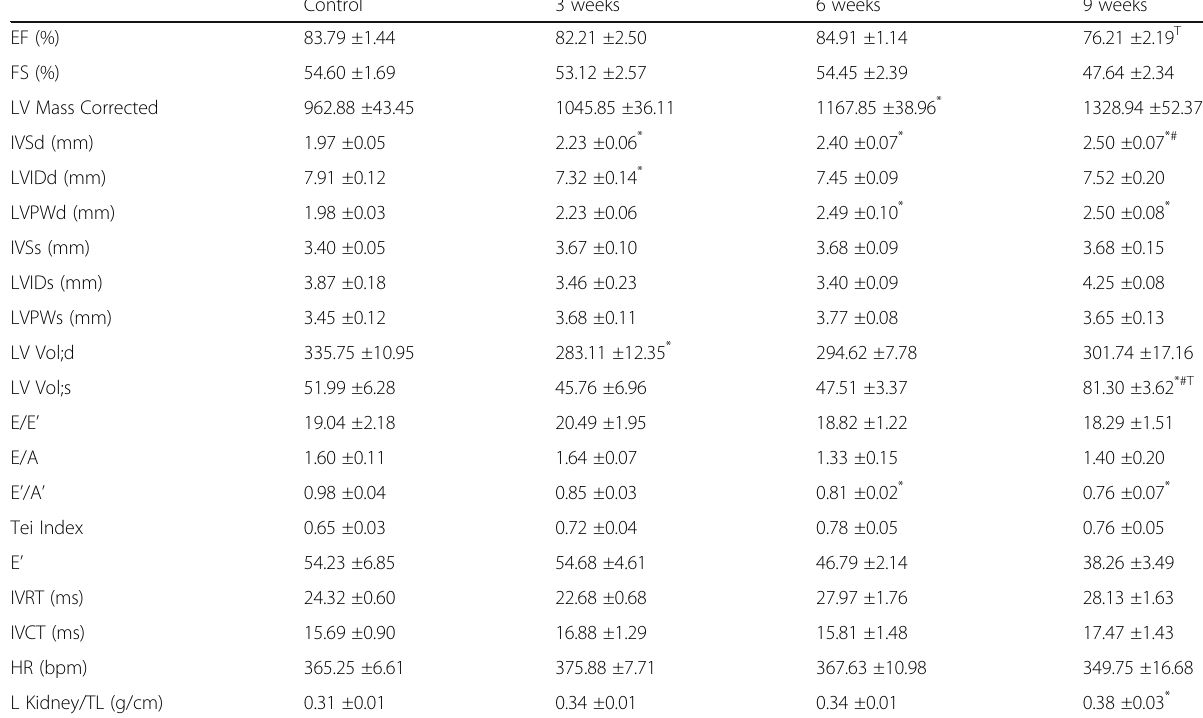
Table 1 Effect of a high salt diet (HSD) on in vivo cardiac function in Dahl salt-sensitive rats